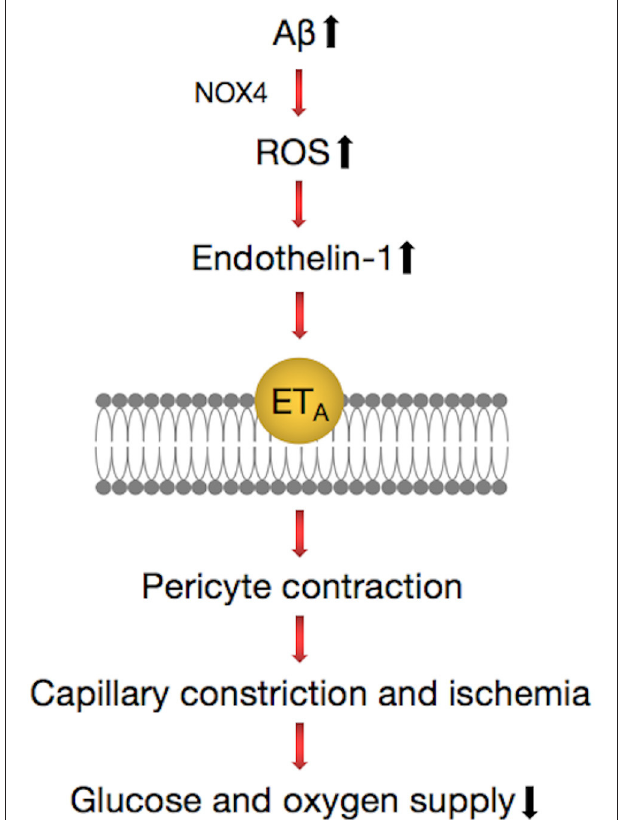
FIGURE 4 | Pathways regulating contractile process of a pericyte around a capillary in the brain. Amyloid beta (A β ) generates reactive oxygen species (ROS) (via NOX4), which evoke the release of endothelin (ET)-1, which can activate contraction by binding to ETA. These lead to the release of Ca2 + , which evokes contraction of pericytes and brain capillaries, which leads to a decrease of the glucose and oxygen supply to the brain tissue. This pathway can be inhibited by blocking NOX4 with GKT137831 (GKT), blocking ETA receptors with BQ-123, and blocking the ET-evoked contraction by C-type natriuretic peptide